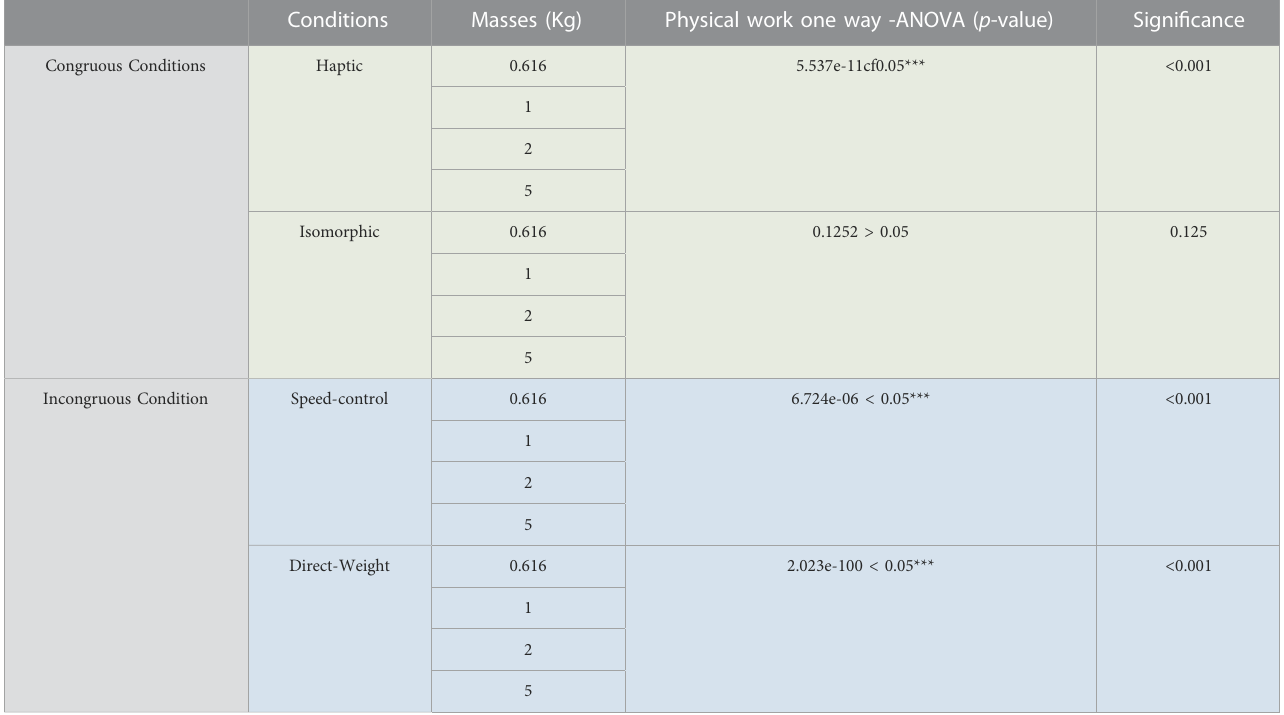
TABLE 2 One-way ANOVA results for the physical work related to different weight in each speci fi c condition. Asterisks show the signi fi cances.